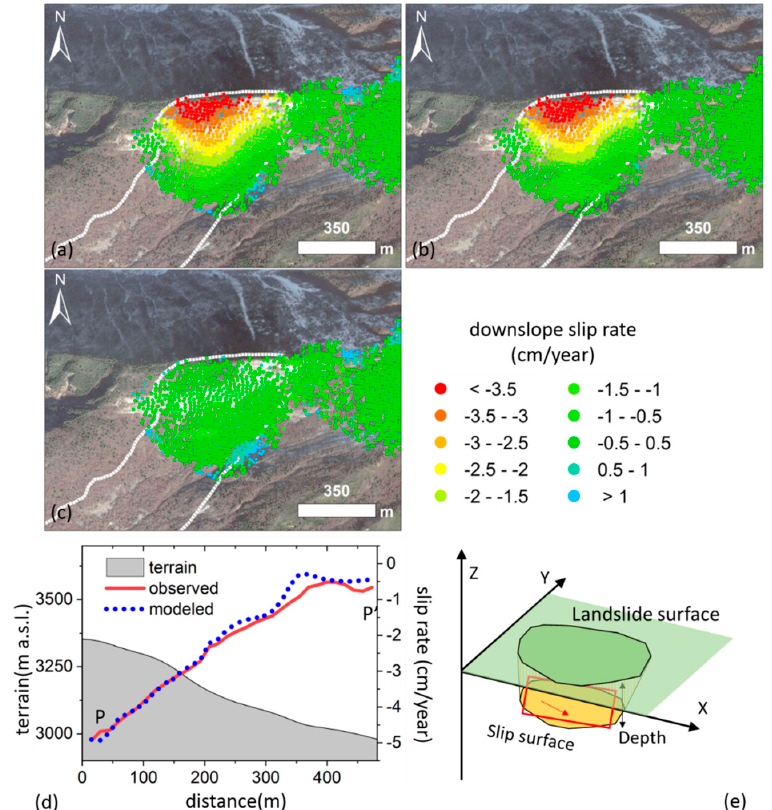
Figure 6. ( a ) Deformation rate along the down slope direction; ( b ) modeled down-slope deformation rate; ( c ) residuals between the observation and the model; ( d ) observed versus modeled slip rates along profile PP’ shown in Figure 3e. ( e ) Landslide inversion model, in which the red rectangle represents the dislocation model used to estimate the thickness and slip distribution of the landslide.